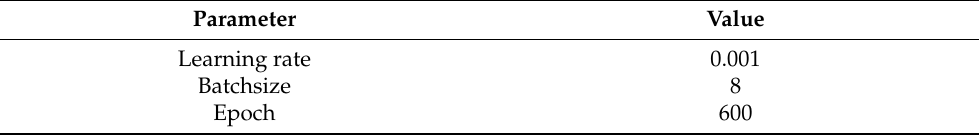
Table 3. Network parameter